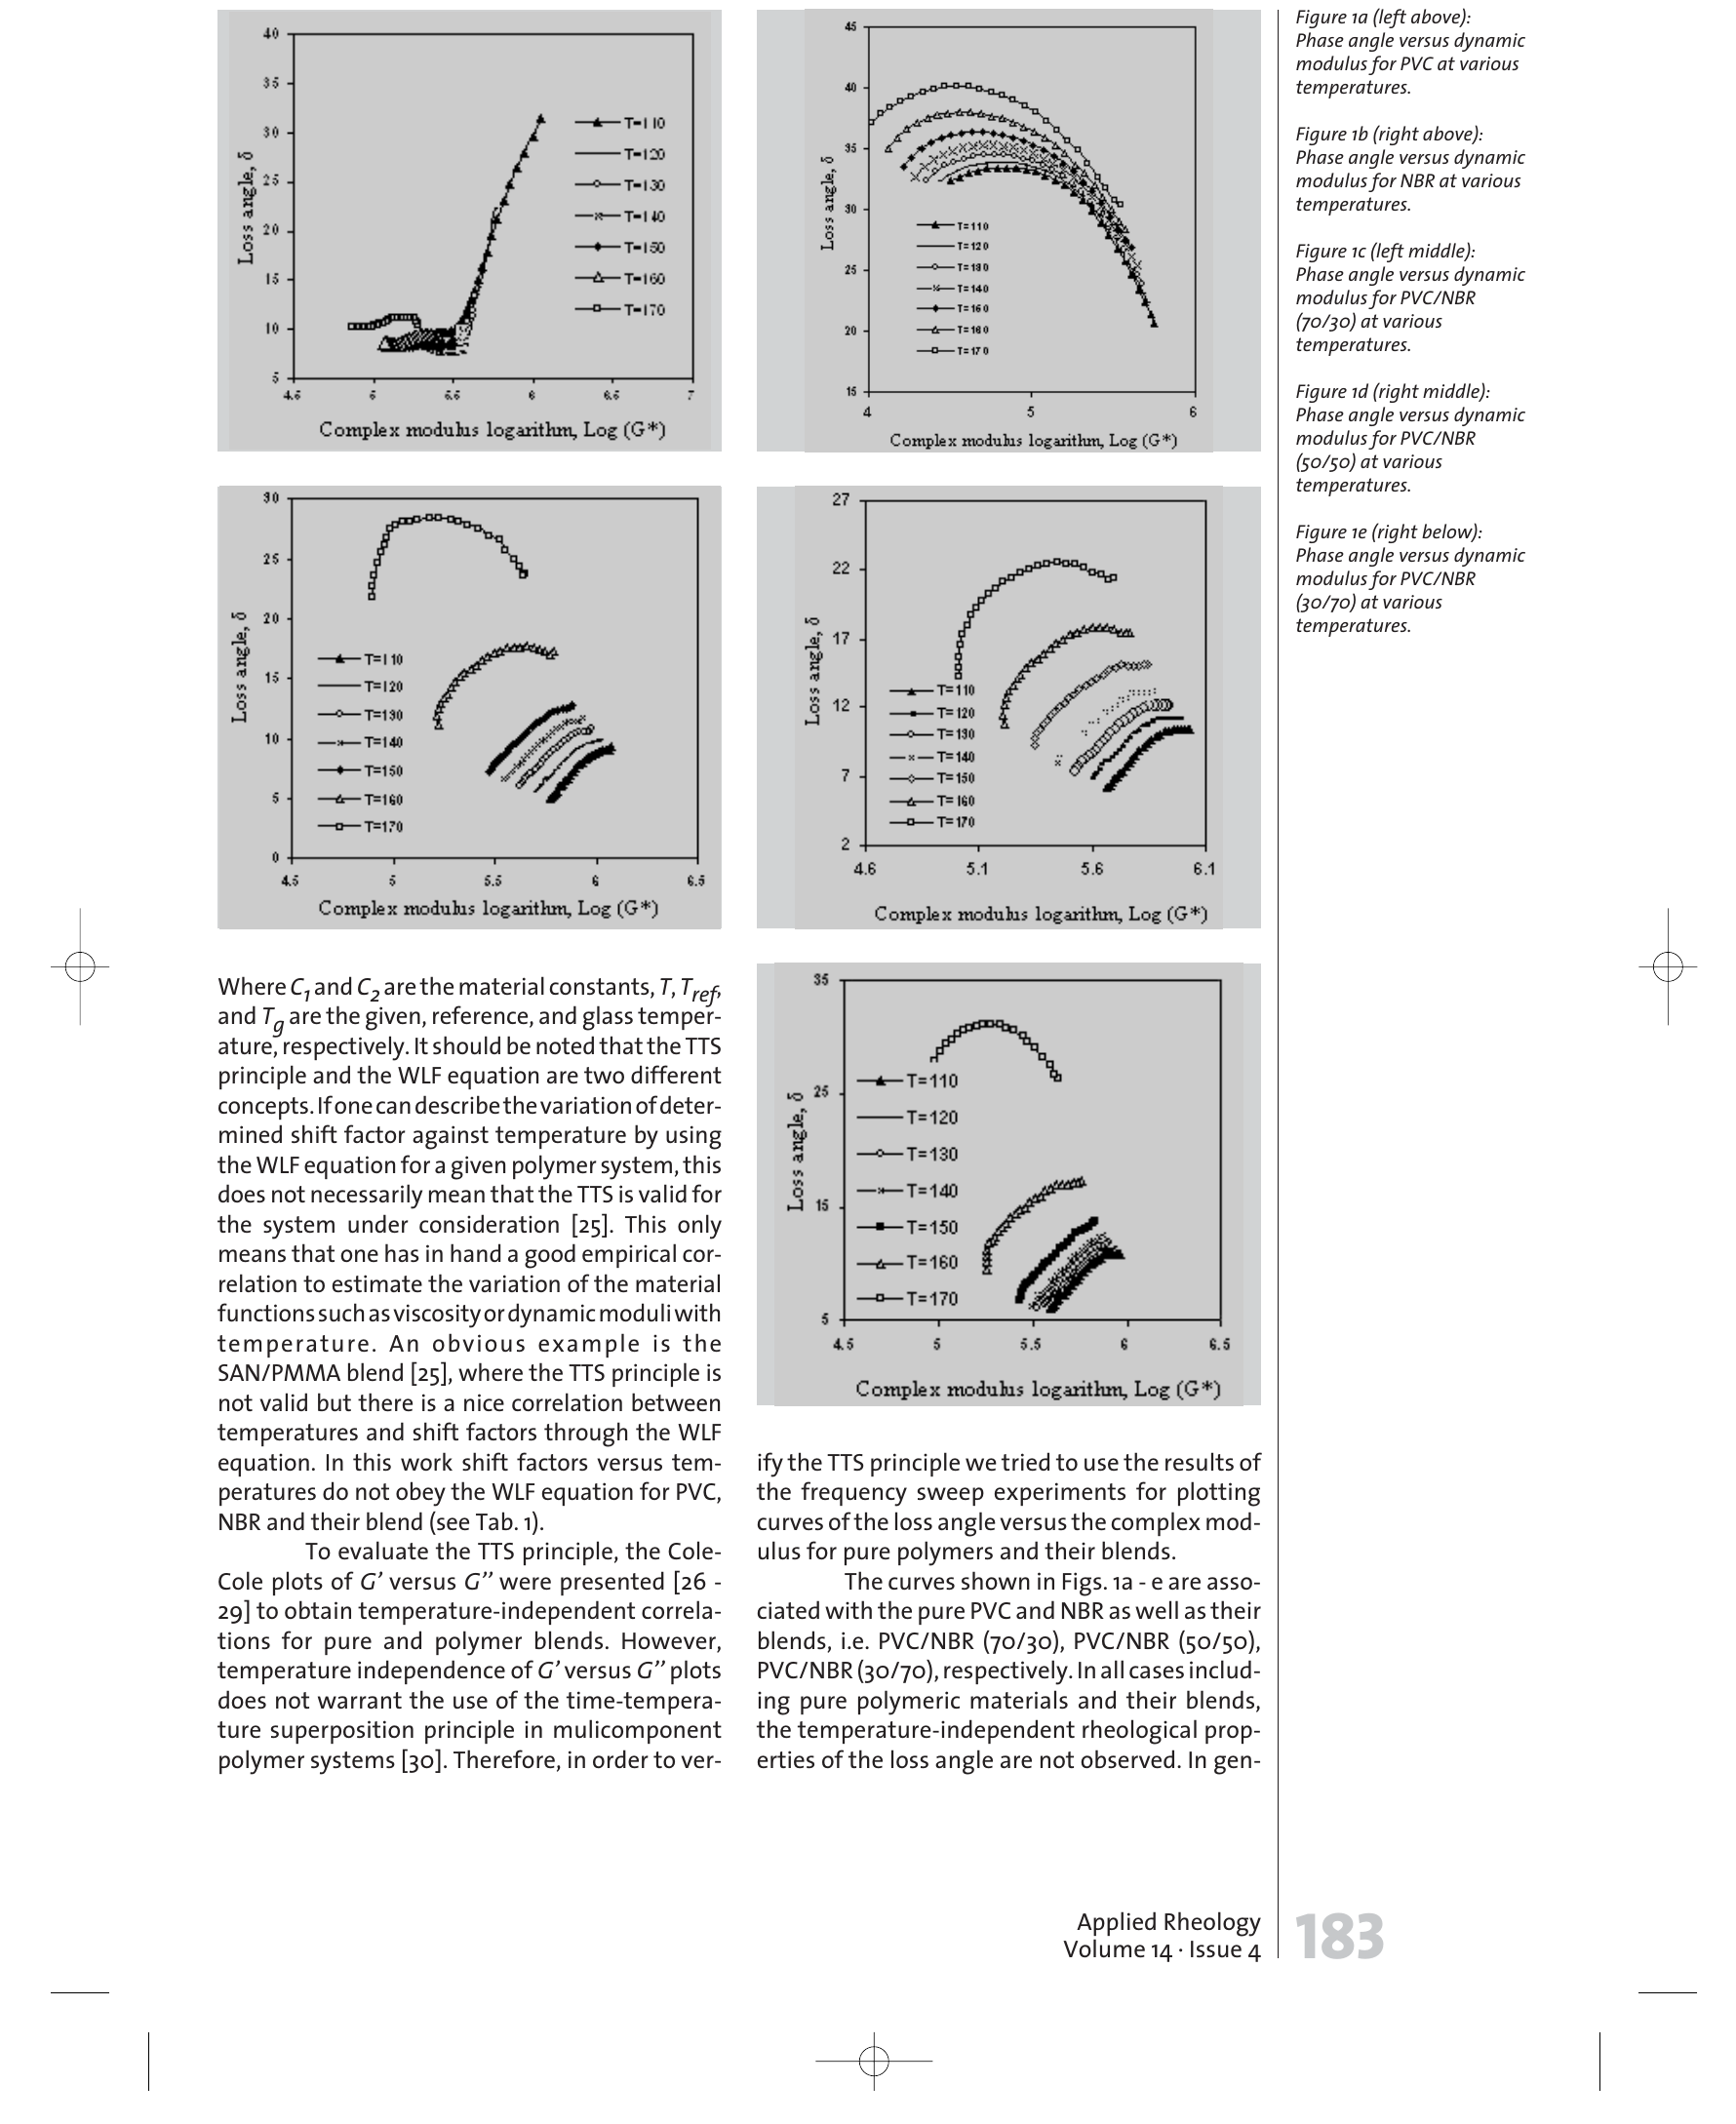
Figure 1a (left above): Phase angle versus dynamic modulus for PVC at various temperatures. Figure 1b (right above): Phase angle versus dynamic modulus for NBR at various temperatures. Figure 1c (left middle): Phase angle versus dynamic modulus for PVC/NBR (70/30) at various temperatures. Figure 1d (right middle): Phase angle versus dynamic modulus for PVC/NBR (50/50) at various temperatures. Figure 1e (right below): Phase angle versus dynamic modulus for PVC/NBR (30/70) at various